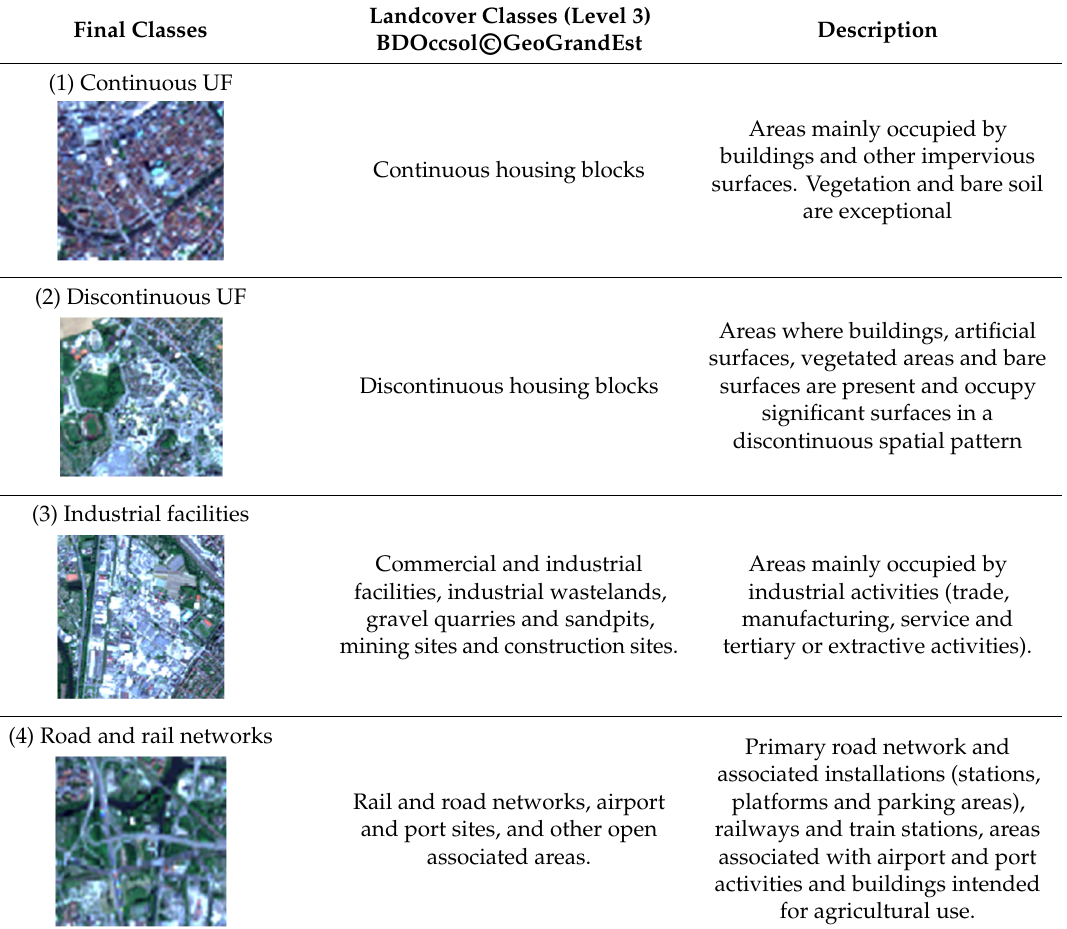
Table 1. List and description of the four urban fabric classes.